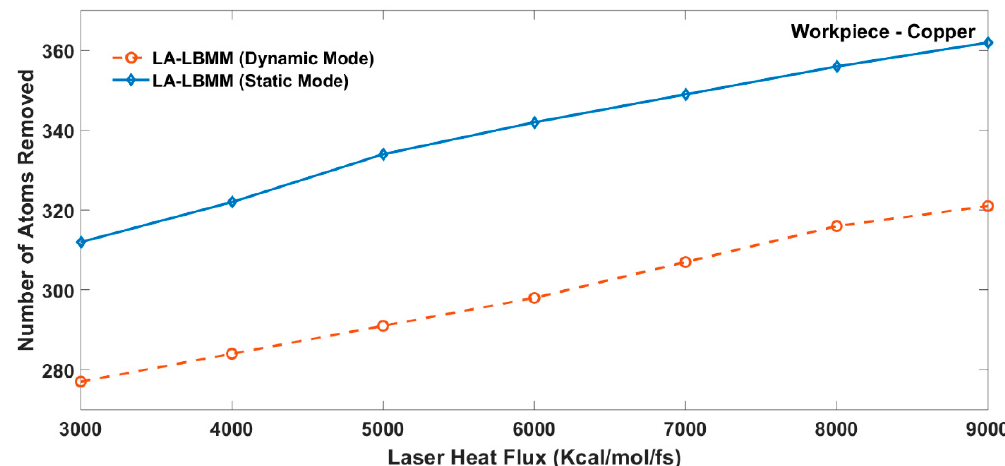
Figure 13. Variation in the Number of Atoms Removed with respect to Heat Flux during the LA-LBMM Process for Static Mode and Dynamic Mode.